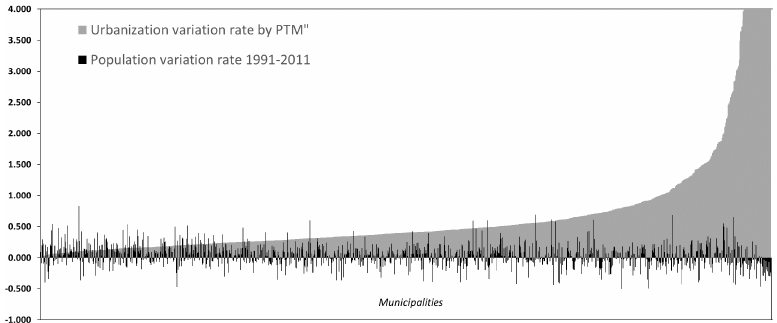
Figure 7. Demographic dynamics for the period 1991–2011 compared to the rate of urban increase per individual municipality according to the Piedmont region PTM.